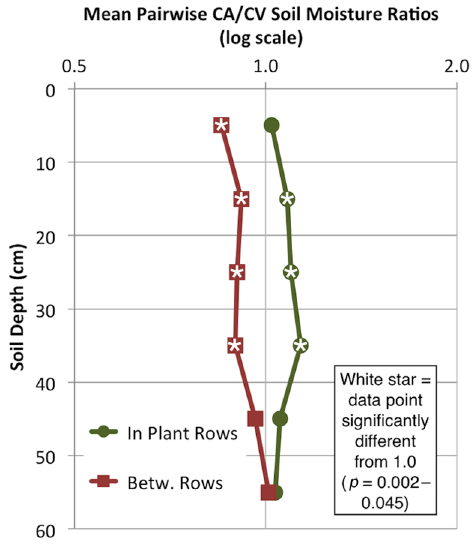
Figure 4. Mean pairwise soil moisture ratios (CA/CV) at six soil depths for two cropping seasons (2013/14 and 2014/15) in the Mumbwa, Monze, and Chipata areas.